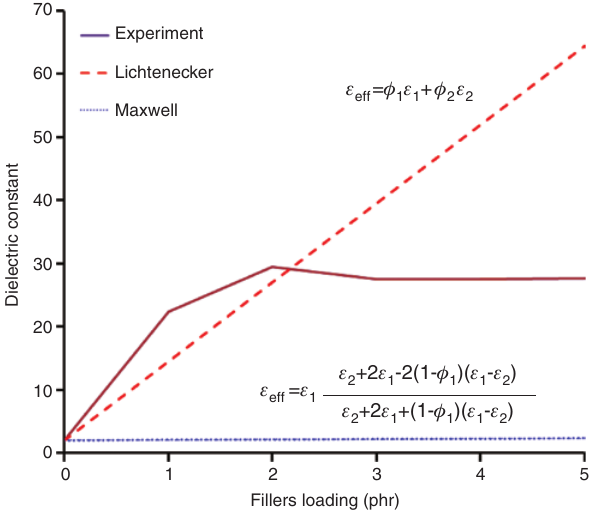
Figure 7: Dielectric constant trend as a function of filler loading.